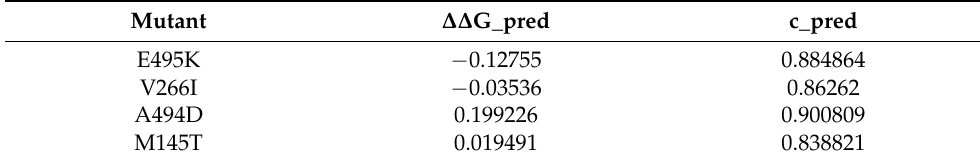
Table 2. Prediction of stabilizing and destabilizing mutations in the HN proteins using the MAESTRO algorithm. ∆∆ G_pred, predicted change in free energy (kcal/mol). Negative and positive values indicate a stabilizing and destabilizing mutation, respectively. c_pred, confidence estimation (0–1) of the